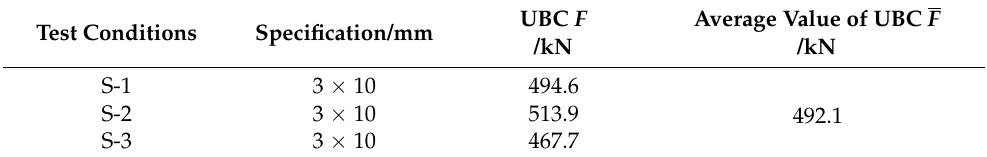
Figure 5. ( a ) Installation, ( b ) Failure. Static load test on the CFRP cable. Table 2. Static load test data of the CFRP cable.